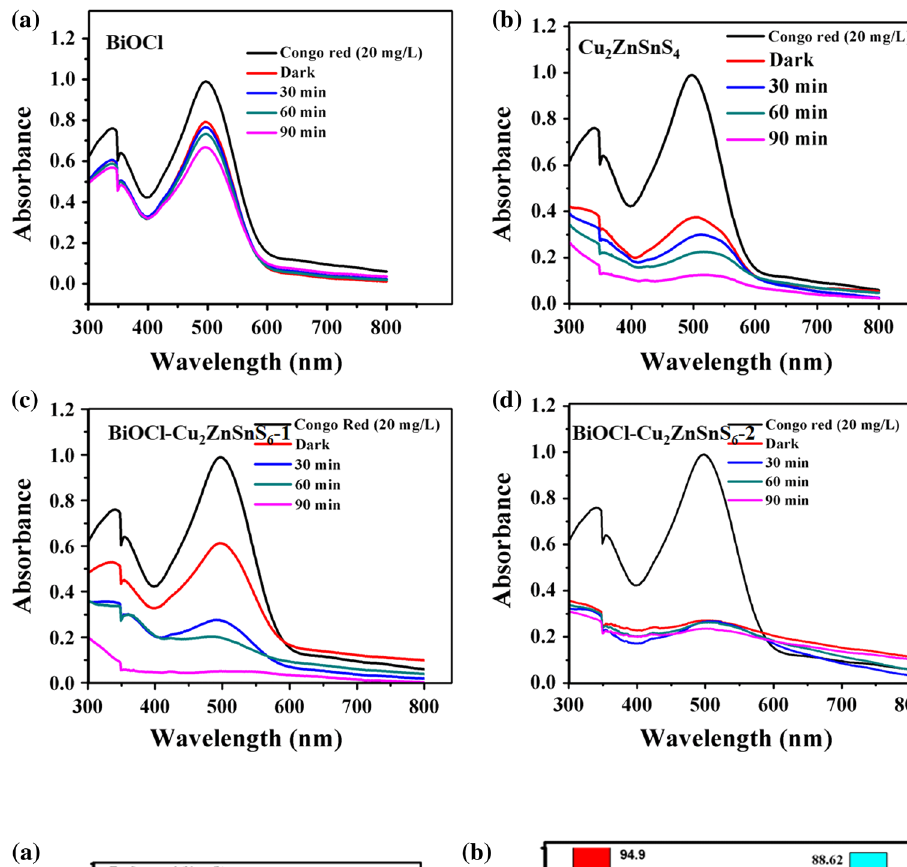
Fig. 9 a Percentage efficiency of photodegradation of Congo red with time. b Effect of different scavengers. c Plot of ln( C 0 / C ) versus irradiation time. d